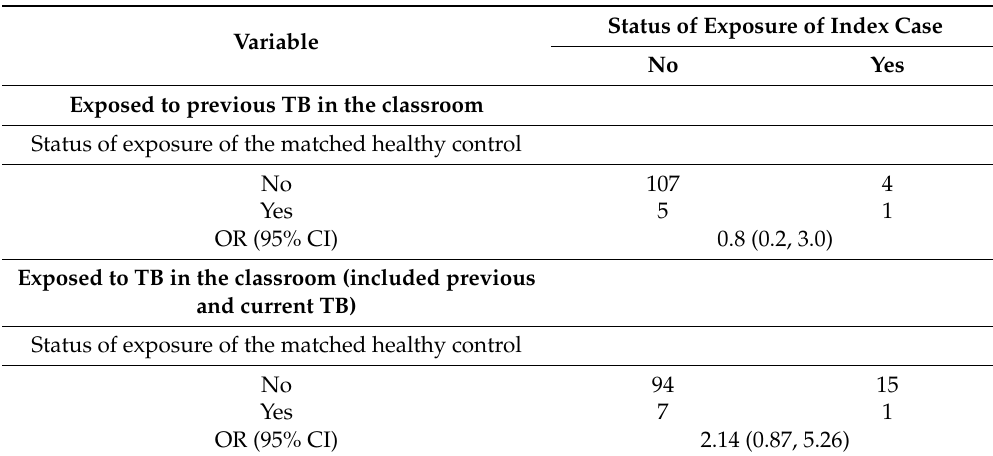
Table 3. Exposed to previous/current TB in classroom of index case and the matched healthy control (117 matched pairs).